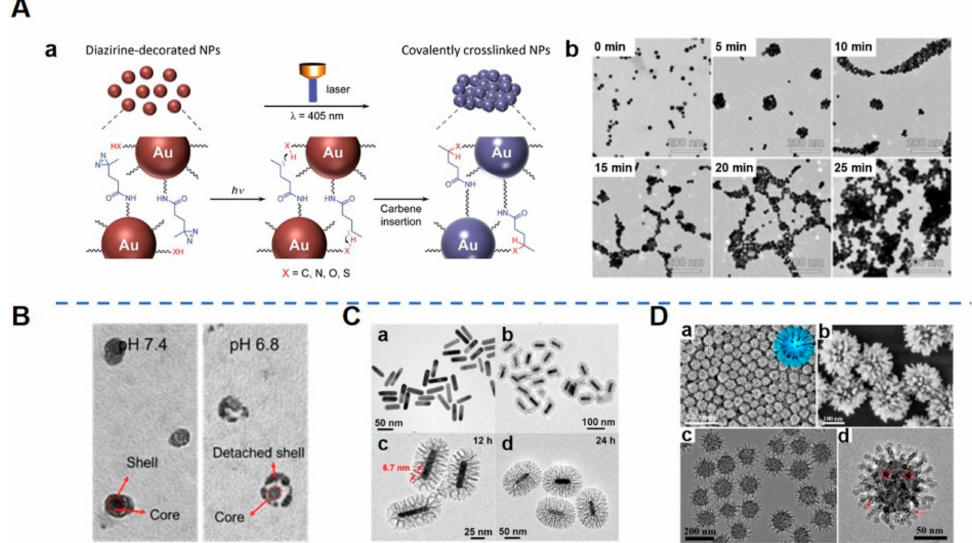
Figure 2. Morphological design of nanoparticles (NPs). ( A ). Light-triggered assembly of gold NPs (AuNPs). ( Aa ) Schematic illustration of a light-triggered assembly of diazirine-decorated AuNPs (dAuNPs). ( Ab ) Transmission electron microscopy (TEM) images of dAuNPs before and after illumination with a 405 nm laser for different periods of time [42]. Aggregation and the agglomeration degree of dAuNPs depended on irradiation time, demonstrating that interparticle cross-linking took place upon laser irradiation. ( B ). TEM images of shell-stacked NPs (SNPs) in PBS at pH 7.4 or 6.8 [45]. SNPs with size and charge dual-transformable ability displayed a clear spherical core–shell structure at pH 7.4, with a size of 145 nm. When SNPs were incubated at pH 6.8, a polyethylene glycol (PEG) corona detached from the core and subsequently the small-sized core with a size of 40 nm was exposed. ( C ). Morphology and structure of gold nanorods (GNRs) and bacteria-like mesoporous silica nanoshell (MSN)-coated GNRs (bGNR@MSN). ( Ca ) TEM image of GNRs. ( Cb , Cc ) TEM images of bGNR@MSN coated for 12 h with silica. The red arrows indicate the size (~6.7 nm) of mesopores. ( Cd ) TEM image of bGNR@MSN coated for 24 h with silica [29]. The morphology of the outside mesoporous silica layer resembled bacterial pili, and the thickness of the mesoporous silica layer could be controlled by changing the reaction time. ( D ). Morphology of virus-like mesoporous silica NPs. ( Da , Db ) Scanning electron microscopy (SEM) and ( Dc , Dd ) TEM images with different magnifications of the virus-like mesoporous silica NPs. The red arrows mark the open tubular structures; the red circles highlight the top view of the open silica nanotubes. The inset of ( Da ) is a structural model for the virus-like mesoporous silica [47]. (Image ( A ) is reproduced with permission from [42] (Copyright © 2016 John Wiley & Sons, Inc.). Image ( B ) is reproduced with permission from [45] (Copyright © 2017 John Wiley & Sons, Inc.). Image ( C ) is reprinted